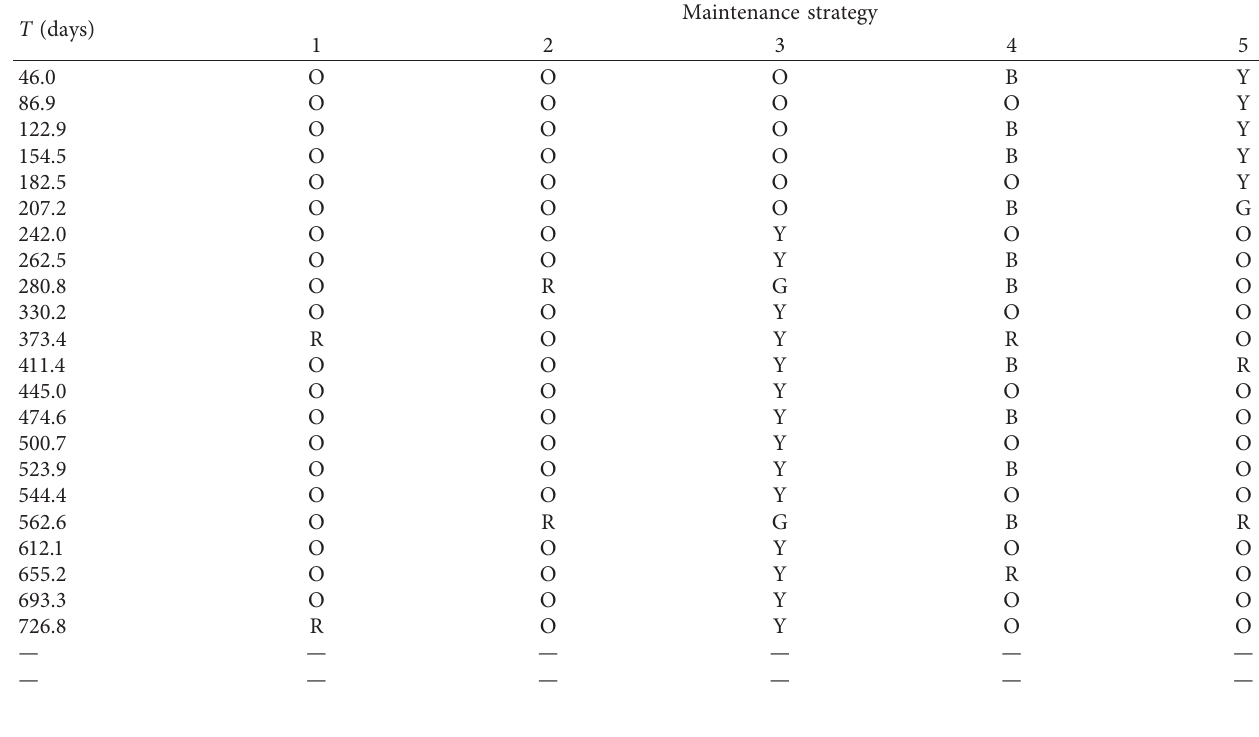
Table 4: The optimal OM schedule for the belt conveyor drive device.